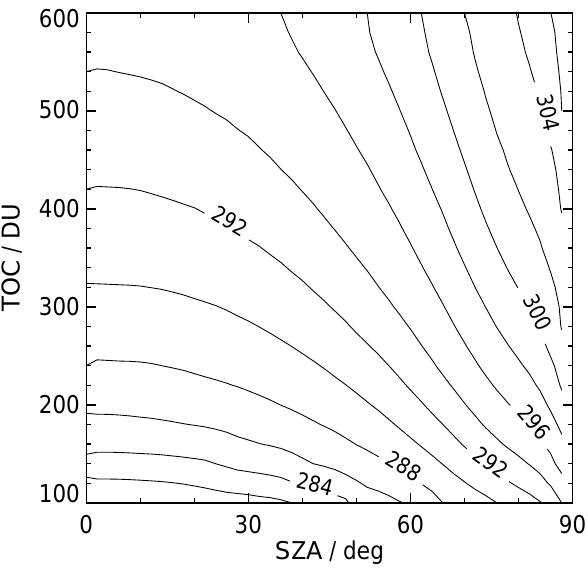
Figure 11. Dark-noise-equivalent actinic flux density F NE instrument 62001 for single measurements at different integration times according to Eq. (14). Table 3. Standard deviations of photolysis frequencies obtained with random noise corresponding to dark-noise-equivalent actinic flux densities (Eq. 14) for instrument 62001. The spectral range is 280–650nm and 300–650nm for numbers in brackets.